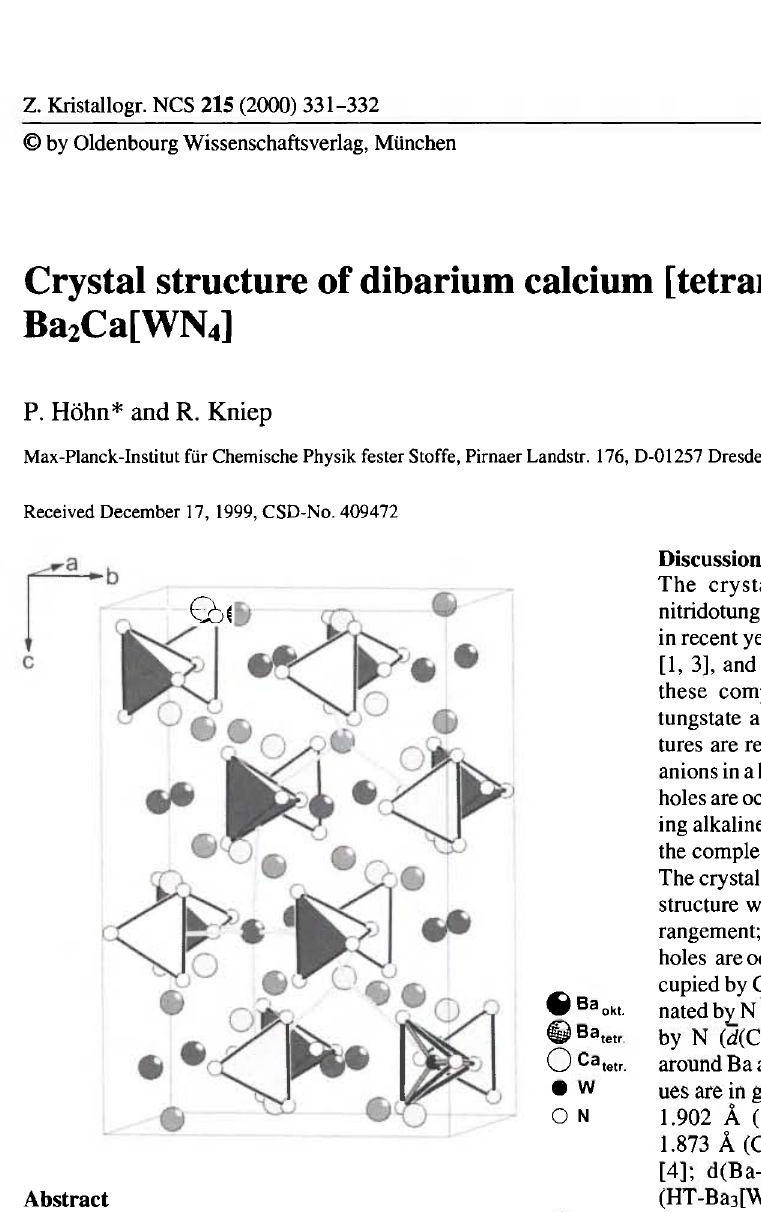
Table 1, Data collection and handling.